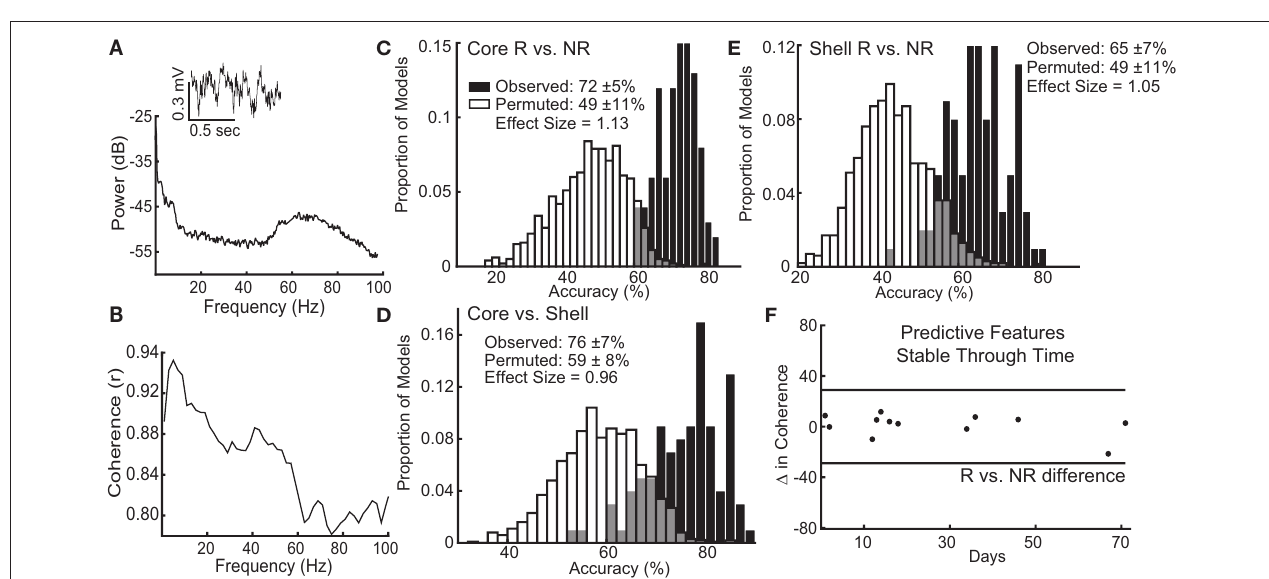
FIGURE 5 | Local field potential (LFP) features recorded from ventral striatum can classify individual stimulation outcomes and are stable through time. (A) Inset of a raw LFP trace from the left NAc core with its corresponding power spectral density plot. (B) Corresponding coherence plot showing phase relationships across frequencies between the left NAc shell and right NAc core. The distribution of accuracies from classifying NAc core (C) and shell (E) stimulation responders (R) from non-responders (NR) using the observed data (black) and the permuted data (white) with mean accuracy ± standard deviation listed for each distribution. Effect sizes between observed and permuted distributions are also shown. (D) Distribution of accuracies classifying the optimal target for stimulation (core vs. shell) for each animal using the observed data (black) or the permuted data (white). (F) The difference in delta coherence (between the left NAc core and right NAc shell) from recording day T1 to T2 (up to 71 days apart) was smaller than the difference observed between the groups of animals that preferentially responded to core or